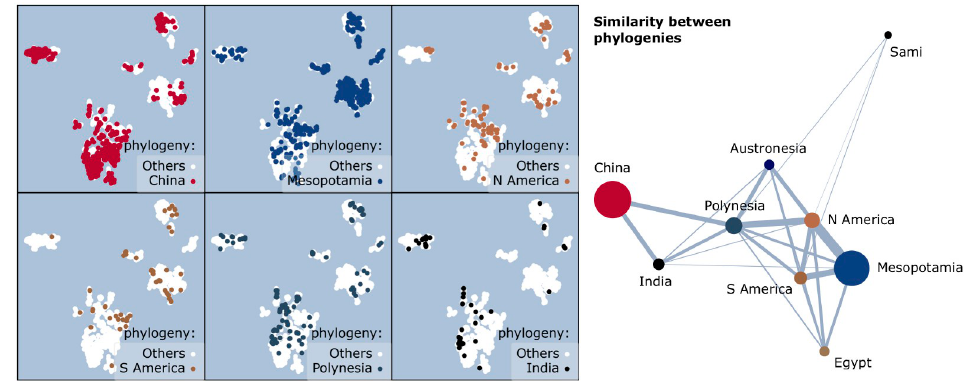
Fig 8. Visual signatures by phylogeny (question I.4). (left) Constellations with common phylogeny are shown in the foreground, over the background of all other constellations. The smallest three phylogenies are not shown: Sami (3 constellations), Egypt (26), and Austronesia (27). (right) The similarity graph between phylogenies. The node size is proportional to the number of constellations per phylogeny, and the edge width to the similarity Δ .